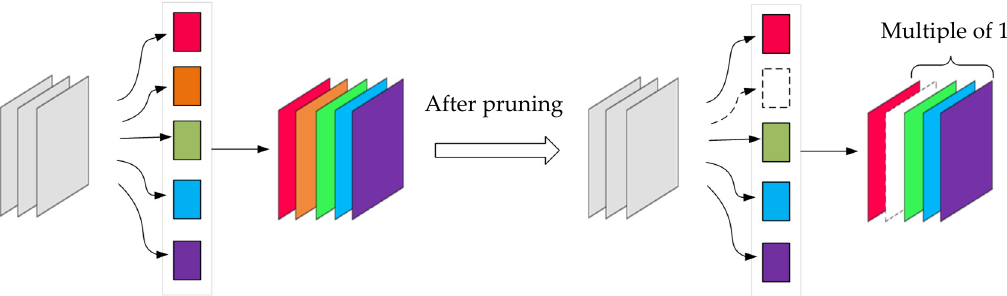
Figure 5. Schematic diagram of network pruning.